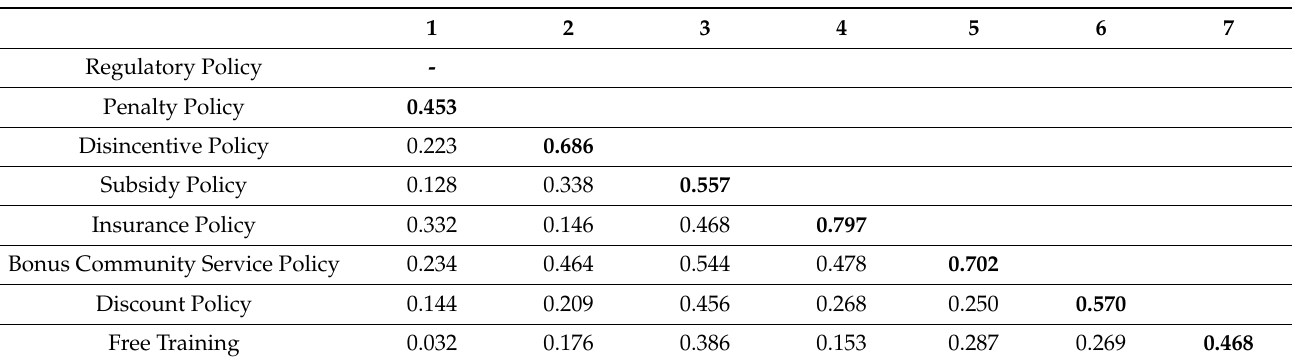
Table 6. HTMT criterion.